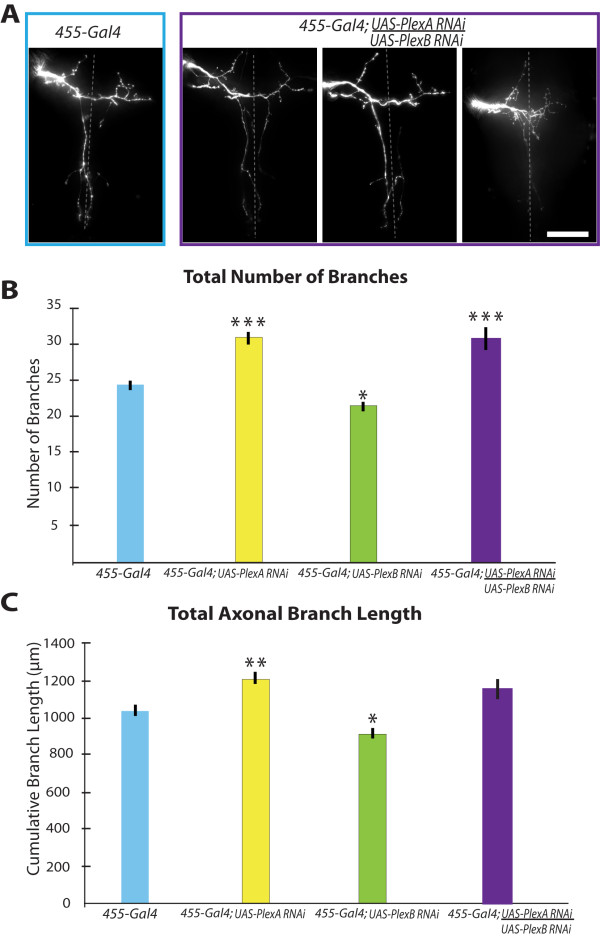
Simultaneous reduction of PlexinA and PlexinB in a single pSc neuron produces both phenotypes. A, Simultaneous expression of PlexA-dsRNA and PlexB-dsRNA within a single pSc neuron results in both wildtype branching patterns and PlexinA mutant branching patterns. Scale bar, 50 μm. B, C, Double knockdown of PlexinA and PlexinB within pSc neurons significantly increases the number of axonal branches, but does not significantly affect the total arbor size.